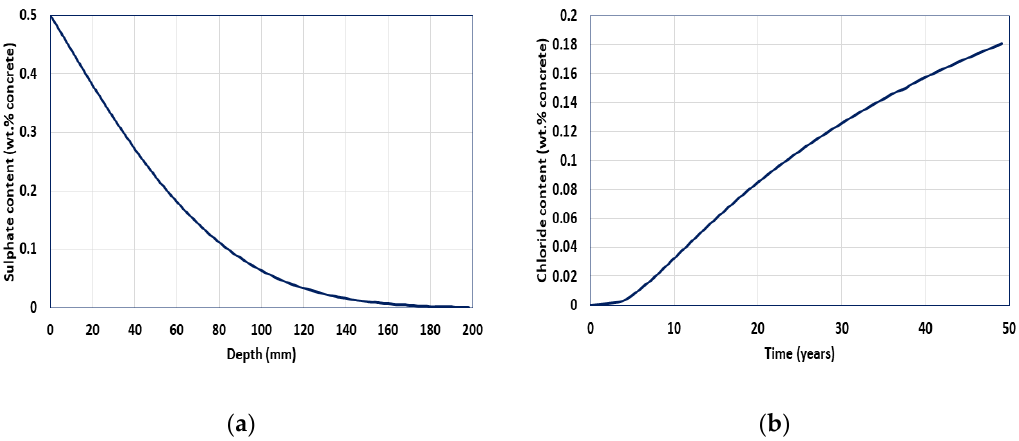
Figure 6. ( a ) Sulfate ion profile with cover depth after 49.1 year; ( b ) increasing sulfate ion at steel location with time.